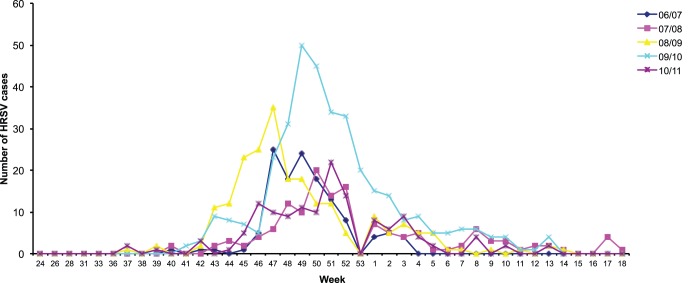
Seasonality of HRSV in Belgium (2006–2011).